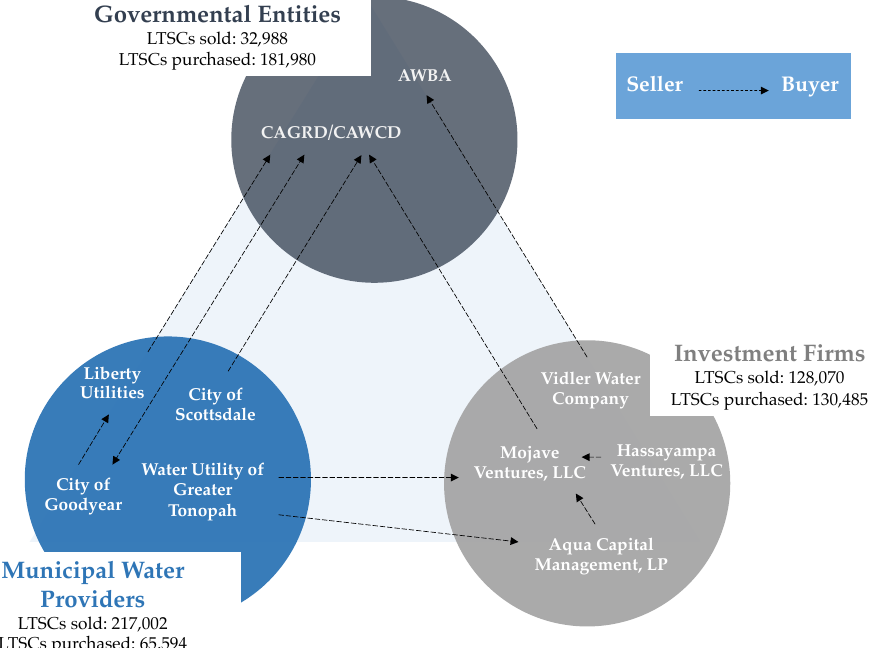
Figure 4. Direction of sales and purchases, and amount of long-term storage credits traded between governmental entities, municipal water providers, and investment firms, from 1994 to 2016 in the Phoenix AMA.